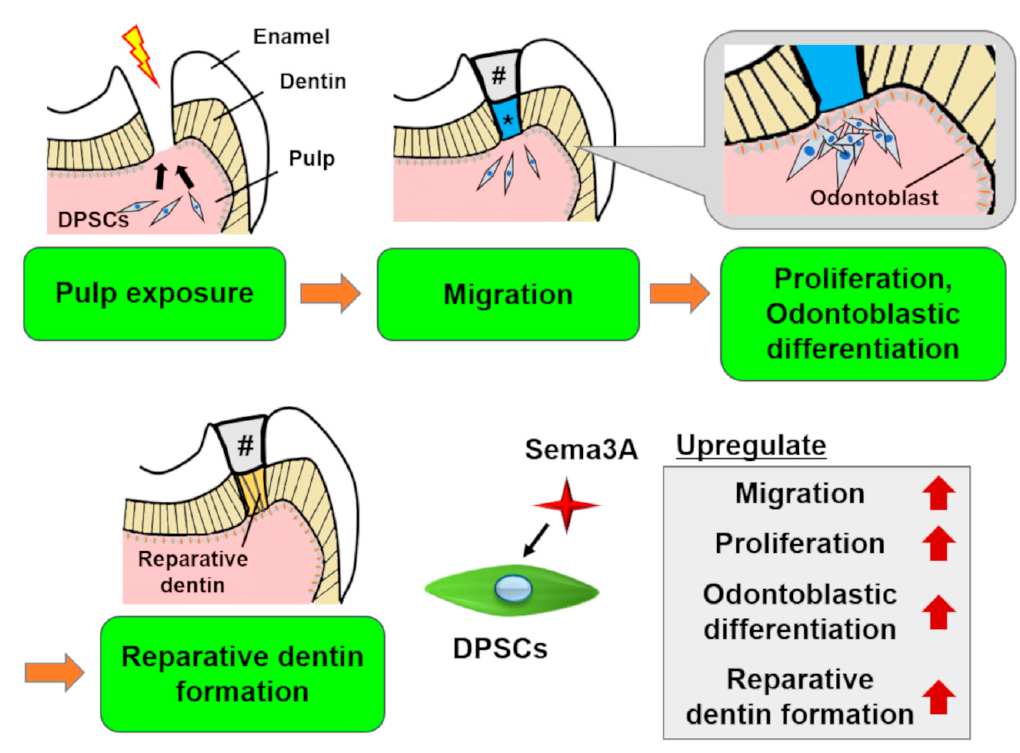
Figure 4. Schema of the effects of Semaphorin 3A (Sema3A) on DPSCs. In case of pulp exposure, DPSCs migrate toward the exposure site, then they proliferate and differentiate into odontoblasts to form reparative dentin. Sema3A can act as a bioactive agent to facilitate these regenerative processes. #, sealing material; *, Sema3A. The original data was published in [40].